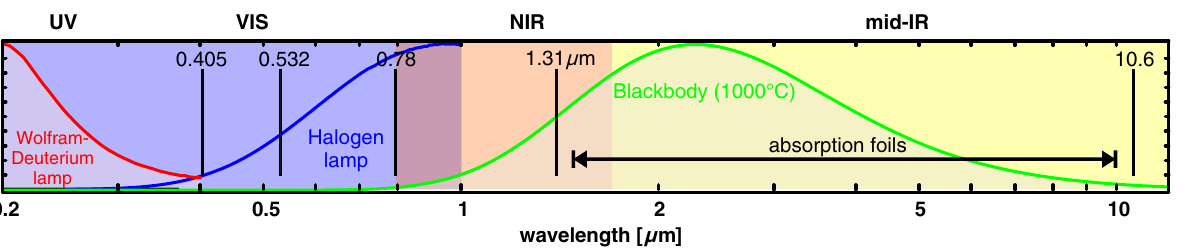
FIG. 9. Overview of the light sources used for the different steps of the calibration procedure comprising continuous light sources (LSs), laser lines (black lines), and a set of absorption foils (TPX, PP, HDPE, and Mylar). The spectra of the HgAr and Ar spectral lamps are not shown